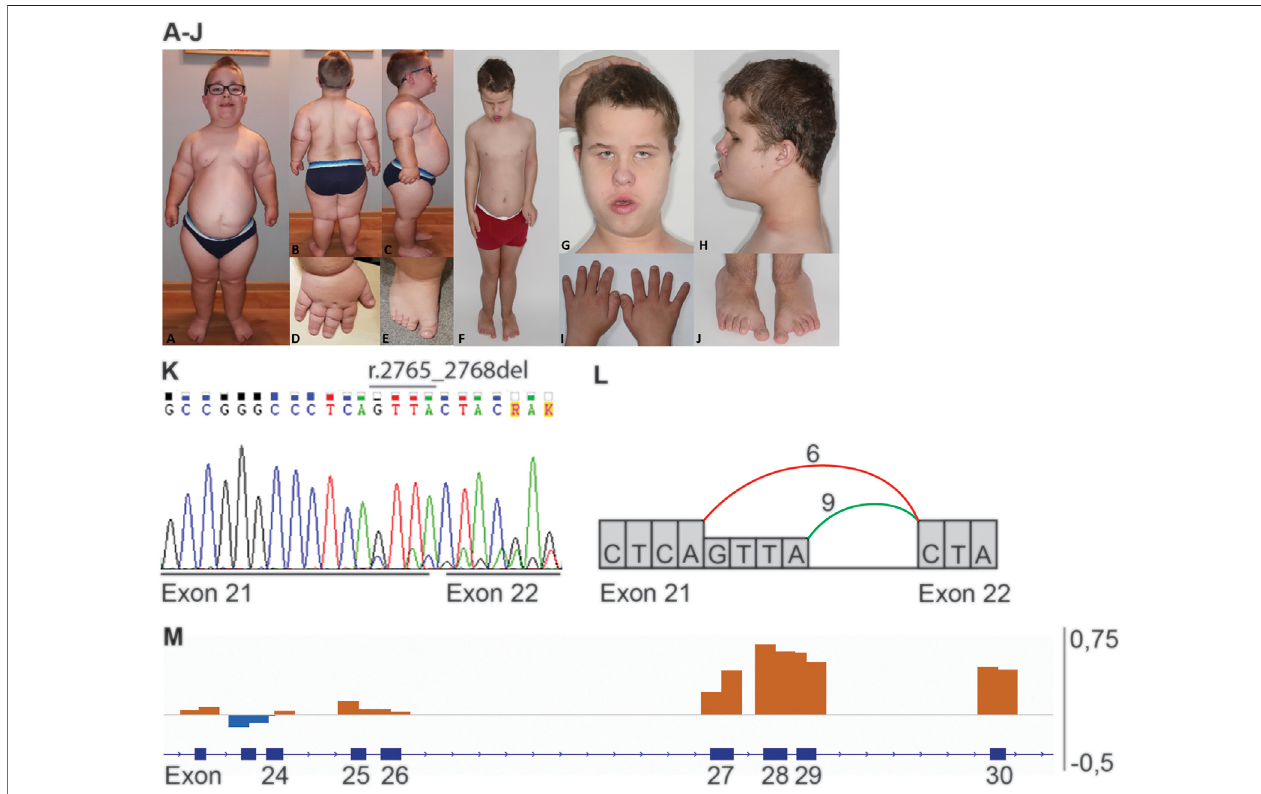
FIGURE 1 | Phenotype and genotype of patients 1 and 2. Proximal limb shortening, narrow thorax, frontal bossing, high forehead, low set and simple ears is present in both patients (A,F,G,H) . (A – E) Clinical features of patient 1: dolichocephalic head shape, full cheeks, micrognathia (A) obesity and hyperlordosis (B,C) , brachydactylyandsandalgap (D,E) . (F – J) Clinicalfeaturesofpatient2:pectusexcavatum (F) ,epicanthalfoldsandtelecanthus,broadnasalbridge,evertedlowerlip (G) , brachydactyly and sandal gap (I,J) . (K) Sanger sequence of heterozygous variant r.2765_2768del in IFT140 (NM_014714.3: c.2767_2768+2del, p.(Tyr923Leufs*28)),representativeforpatient1and2. (L) SchematicrepresentationofthesplicingeffectcausedbyIFT140r.2765_2768del.Thecolouredlinesindicate the splicing between exons, in green the wildtype splicing between exon 21 and 22 and in red the aberrant splicing seen in patients 1 and 2. (M) Schematic overview